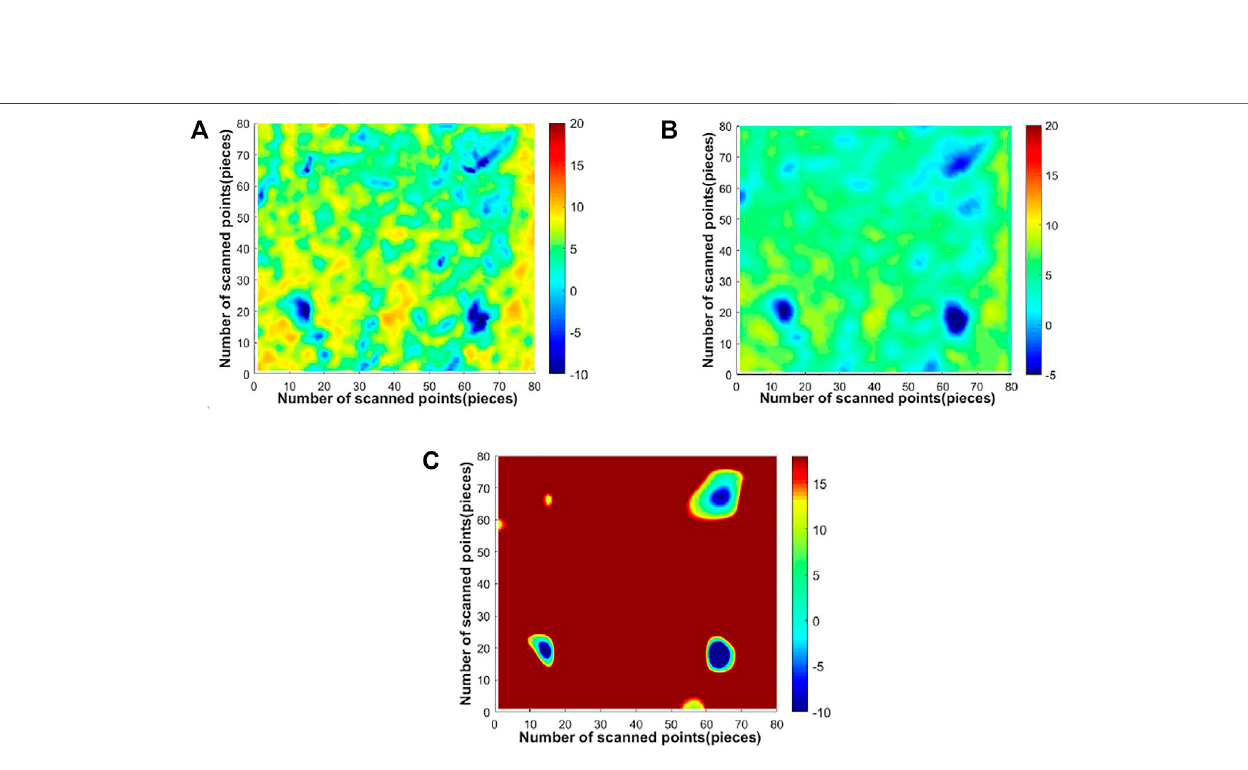
Frontiers in Physics |